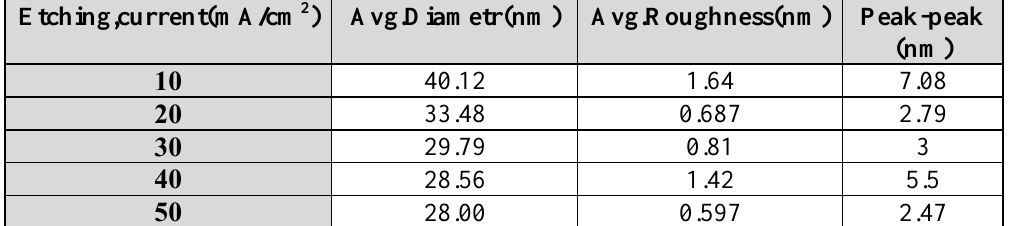
Table 2: AFM parameters for porous silicon with constant time and different etching current 10, 20, 30, 40 and 50